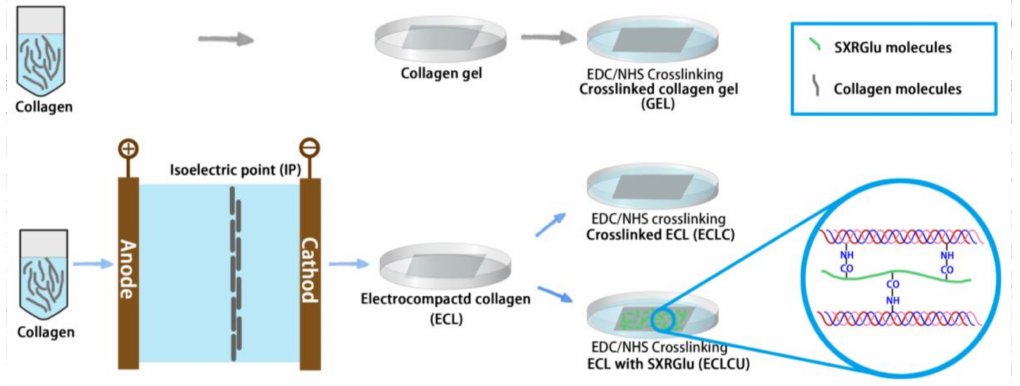
Figure 1. Schematic illustration of the preparation of electrocompacted collagen matrices (grey and green rods represent collagen and collagen/sulfated xylorhamnoglycuronan (SXRGlu) molecules respectively, colorful line in the blue circle represents collagen molecules). The colorful waves in the magnification represent electrocompacted collagen attached to SXRGlu